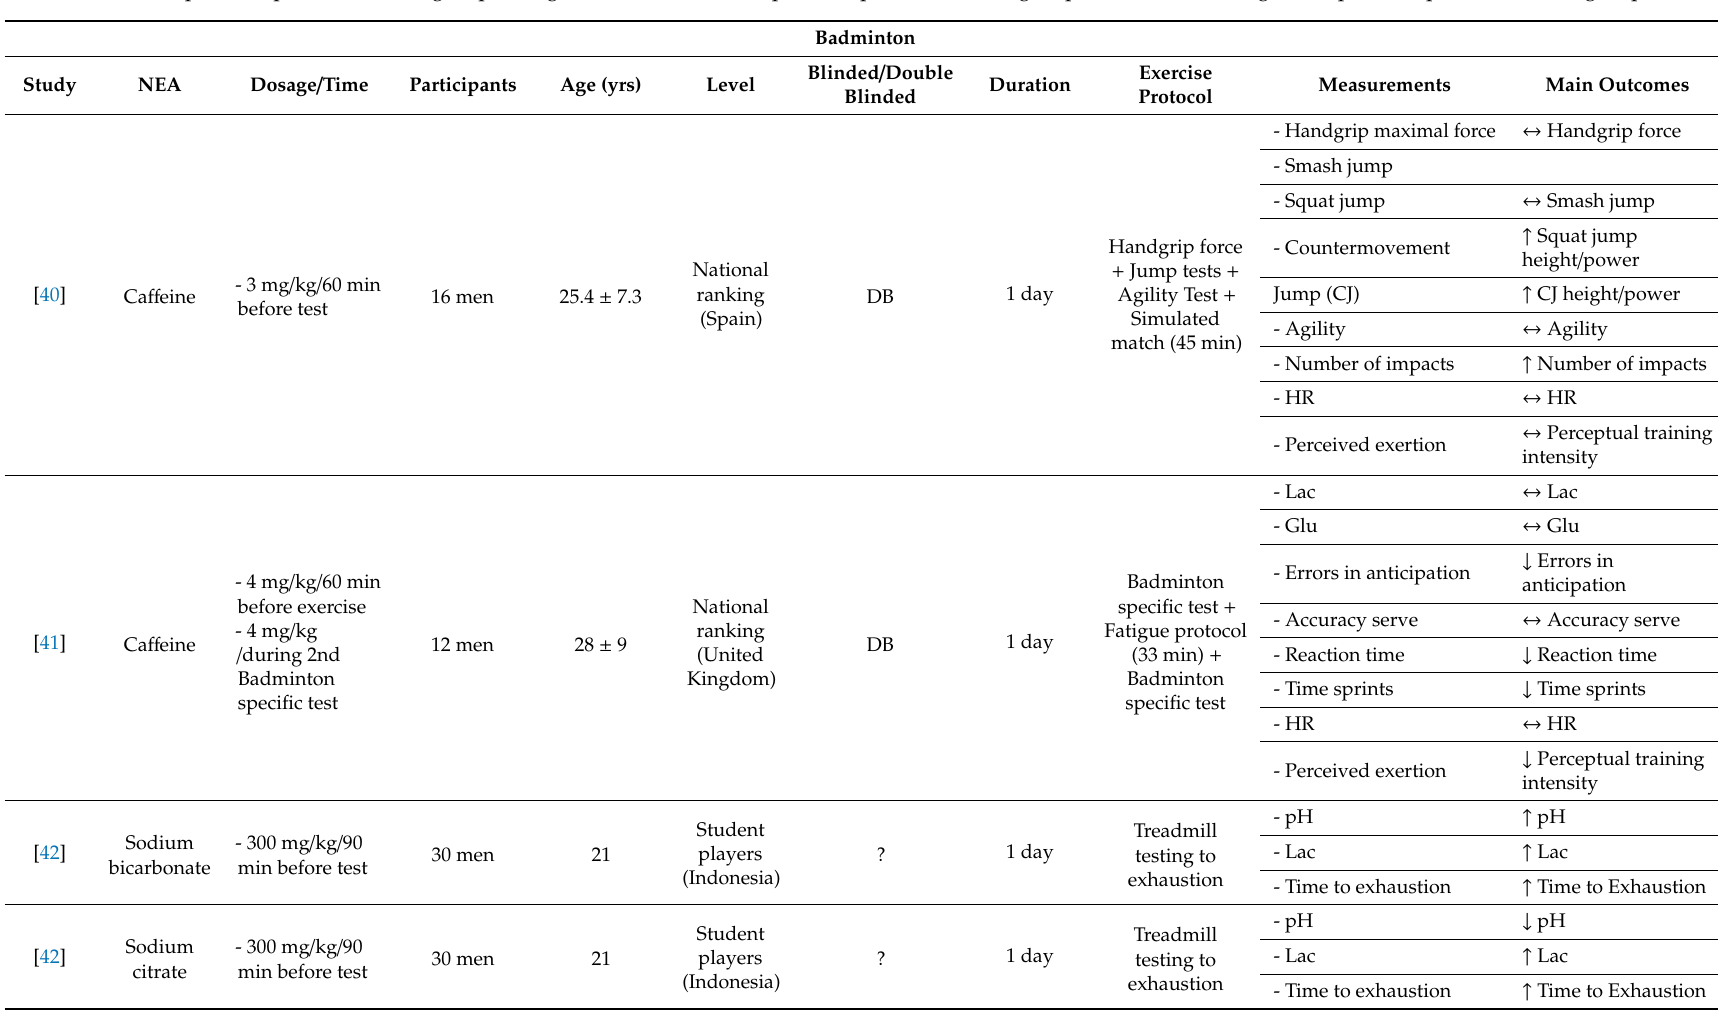
Table 3. Included studies on nutritional ergogenic aids in badminton, squash, and paddle. Glu: Blood glucose; HR: Heart rate; Lac: Blood lactate. ↑ : Significant increase compared to placebo / control group; ↓ : Significant decrease compared to placebo / control group; ↔ : without changes compared to placebo / control